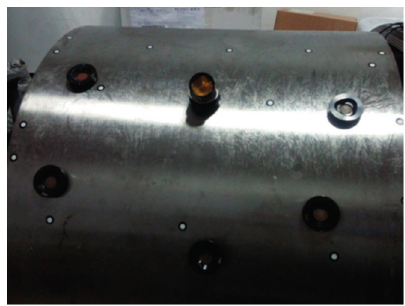
Figure 11. The ring gauge with the reference global position